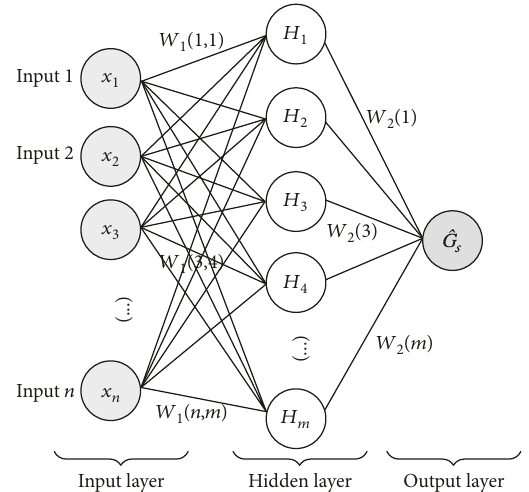
Figure 2: MLP, feed-forward neural network.